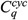
Average rank of clustering coefficients Cqcyc (A), Cqmid (B), Cqin (C), Cqout (D) and Cqall (E) as defined in Eq (21) for the ITN in 2005.